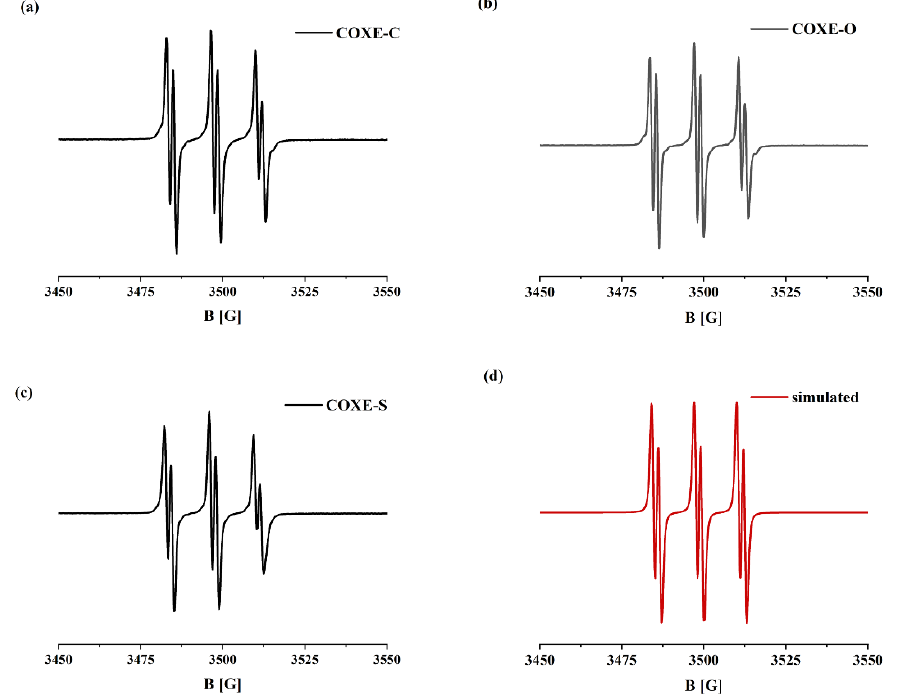
Figure 5. ESR spectra for radicals generated by ( a ) COXE-C, ( b ) COXE-O, ( c ) COXE-S and ( d ) simu- lation upon 400 nm LED irradiation trapped by PBN in tert -butylbenzene within 10